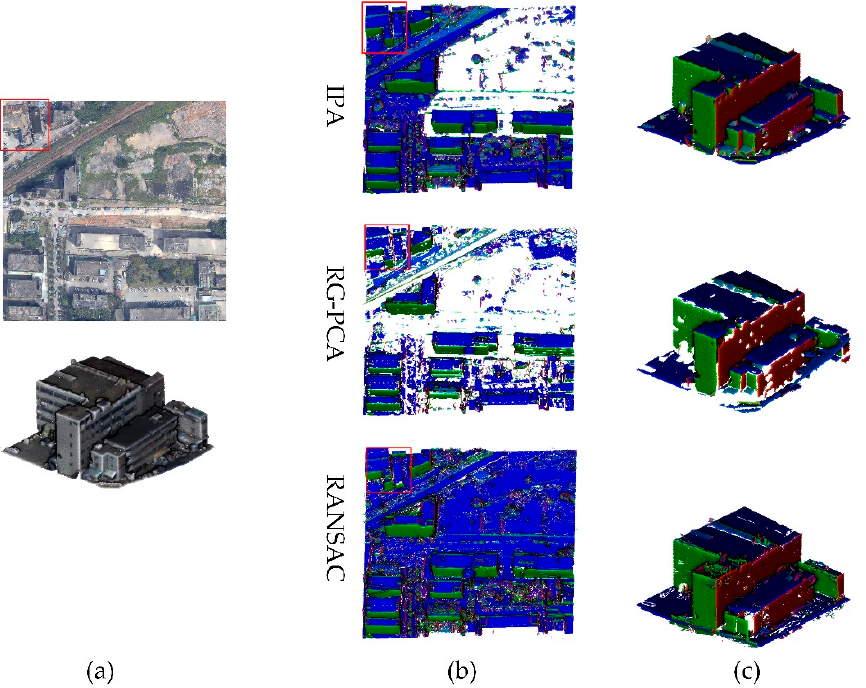
Figure 10. Comparison of planar surface extraction from the point cloud of tile 3.